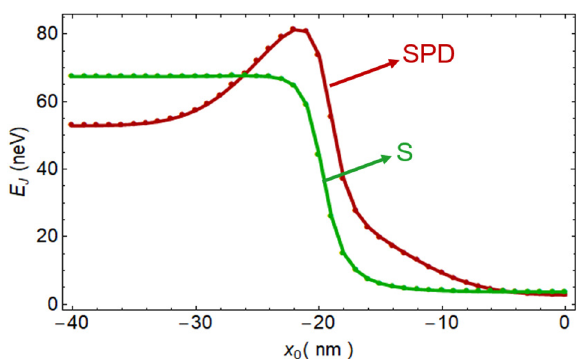
Fig. 5 Exchange splitting as a function of the interface step location. Two-electron exchange interaction as a function of the interface atomic step position, with different CI basis sets ( s only, or with spd orbital states). The center of the DQD lies at the origin x 0 = 0. The center of the left dot is at x 0 = − 20 nm, and the dot radius is = 8 ℓ 0